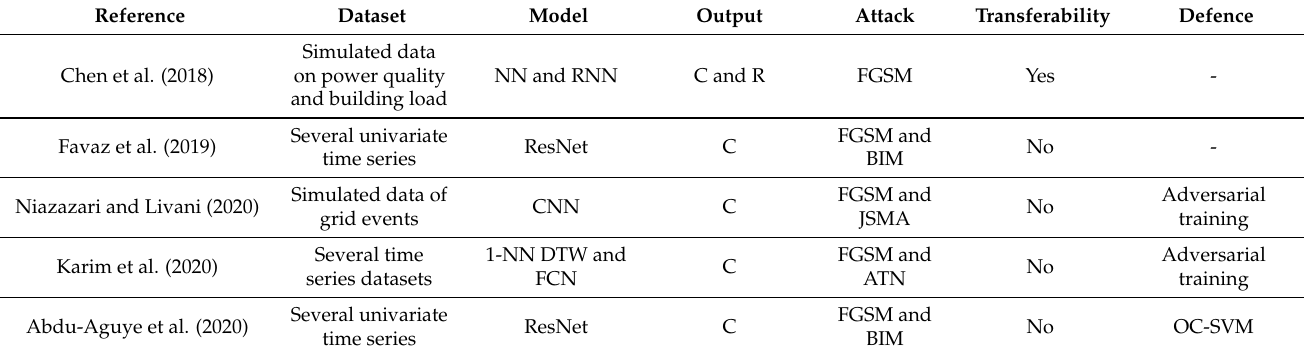
Table 1. Comparison among the related works. C stands for classification and R for regression.